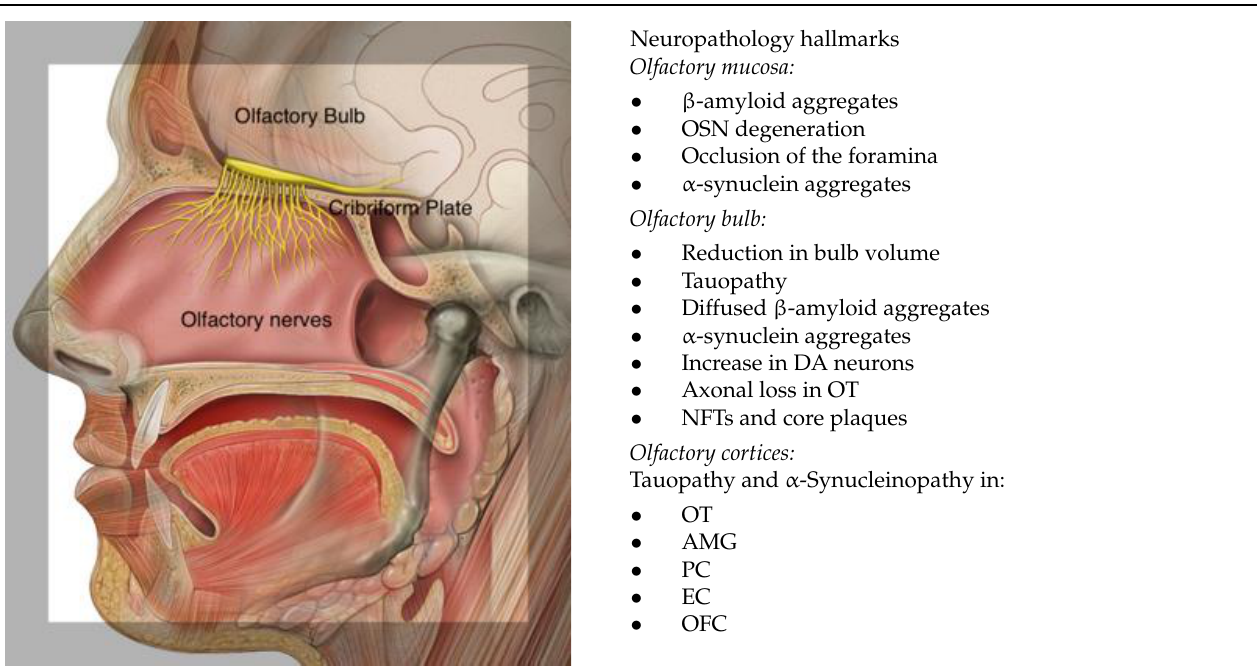
Table 3. Neuropathological processes of the olfactory system in neurodegenerative diseases. Gross anatomy of the nose, the olfactory nerve, and the olfactory bulb, and cellular and molecular neuropathology. (OSN: olfactory sensory neurons, DA: dopaminergic, OT: olfactory tract, PC: piriform cortex, AMG: cortical nucleus of the amygdala, EC: entorhinal cortex, OFC: orbitofrontal cortex.)